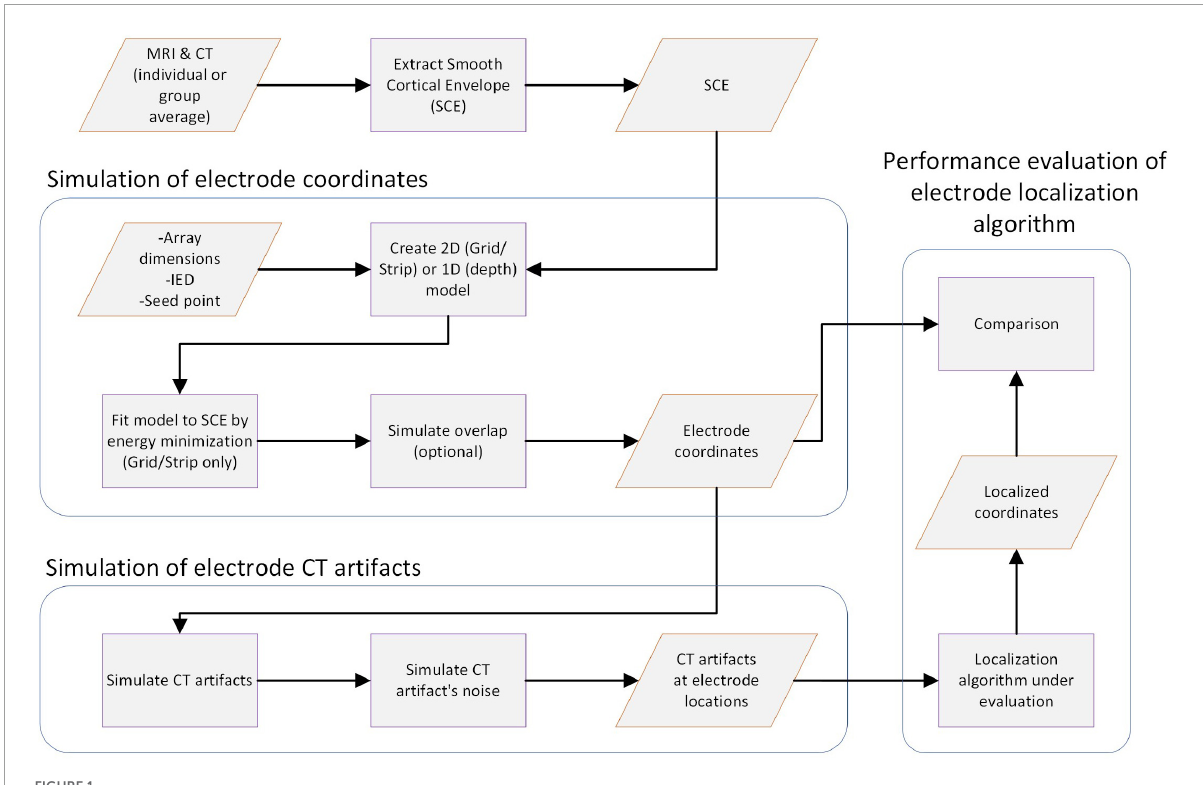
FIGURE1 Workflow for simulating electrode CT artifacts and evaluating localization algorithms. The main steps of the workflow are shown in the diagram. First, a Smooth Cortical Envelope (SCE) is obtained from an individual or average atlas image. Electrode arrays are modeled according to design parameters and fitted over the SCE (grids) or placed within the brain tissue (depths) to obtain the electrode coordinates. Then, CT artifacts are simulated at each electrode coordinate, considering the electrode type and spatial orientation. Subsequently, noise is added to simulate different realistic scenarios. CT artifacts are then fed into the localization algorithm under evaluation. Finally, localized coordinates are compared with the ground truth electrode coordinates. Knowing the true electrode coordinates allows a correct estimation of the localization error and its sensitivity to different noise levels. Moreover, the results can be easily replicated. Orange parallelograms represent data, and purple squares represent